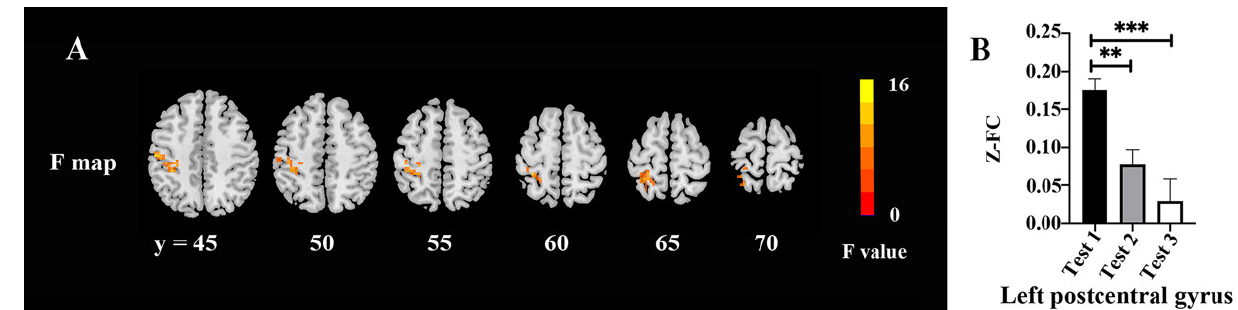
Figure 4. FC changes among the three time points: ( A ) Difference of FC maps among the three time points; ( B ) extracted clusters of significant FC alteration in three time points. ** p < 0.01 and *** p < 0.001. Table 6. Regional information of changed FC in repeat ANOVA.